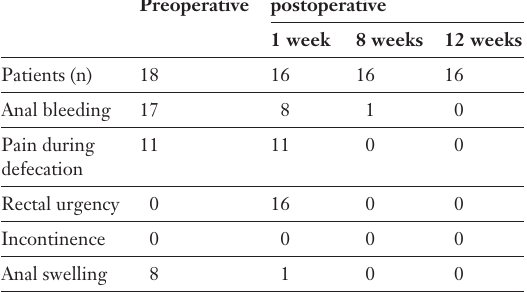
Major pre- and postoperative